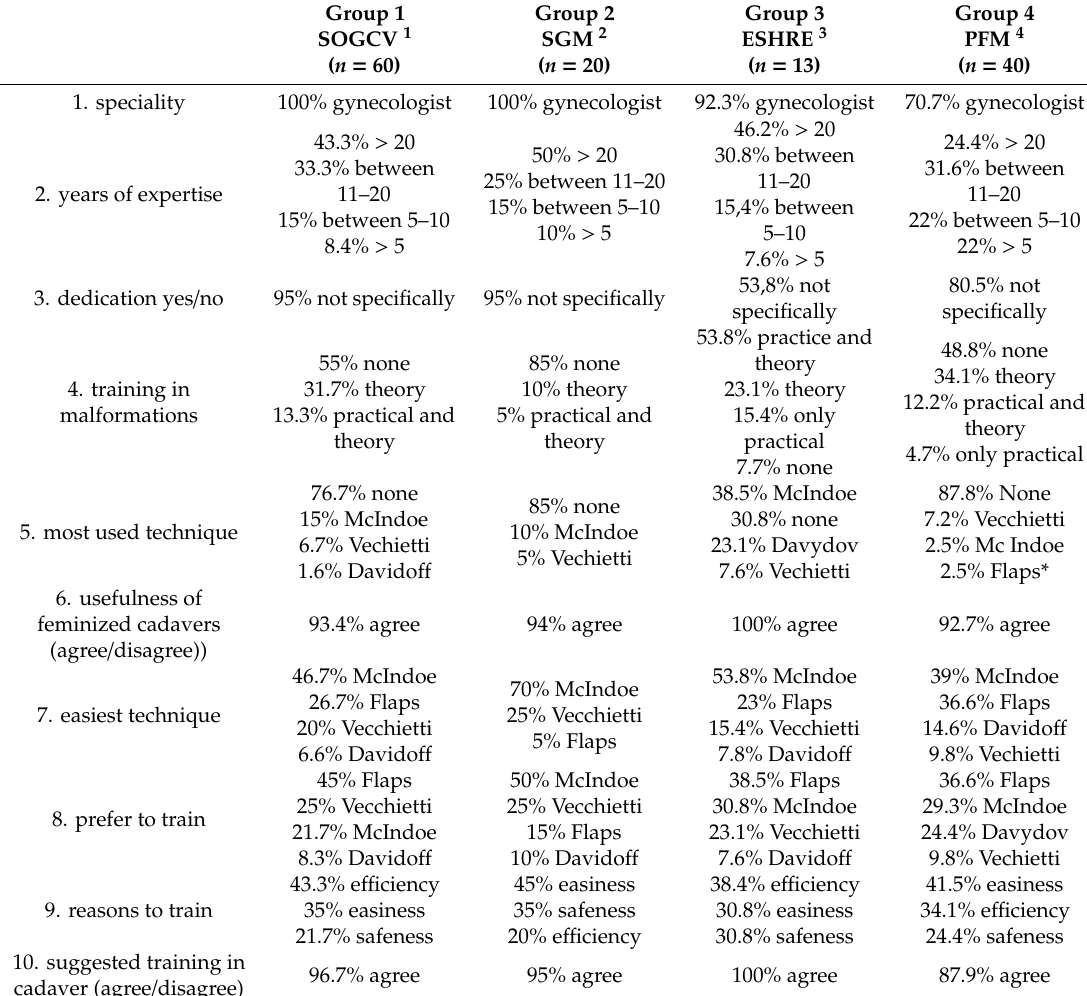
Table 1. Answers according to the di ff erent